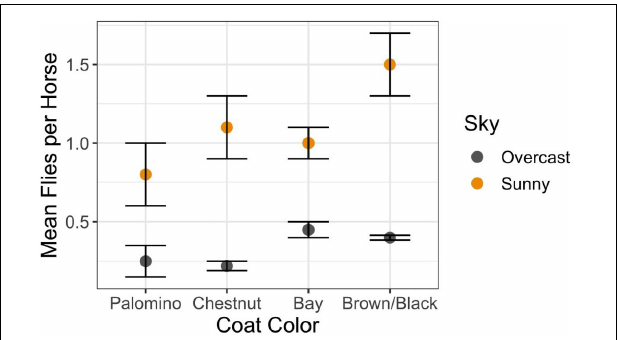
FIGURE 2 | Relationship between the morphological trait of coat color under different sky conditions on per capita fly loads (mean and standard error: Interaction Sky Condition × Coat Color = F 3 , 622 = 5.94; p < 0.0005). Coat colors range from the light golden Palominos with cream-colored manes to reddish-brown bodies and manes of Chestnuts, and to the brown bodies of the Bays highlighted with blackish manes, to those with solid dark brown or black bodies with matching